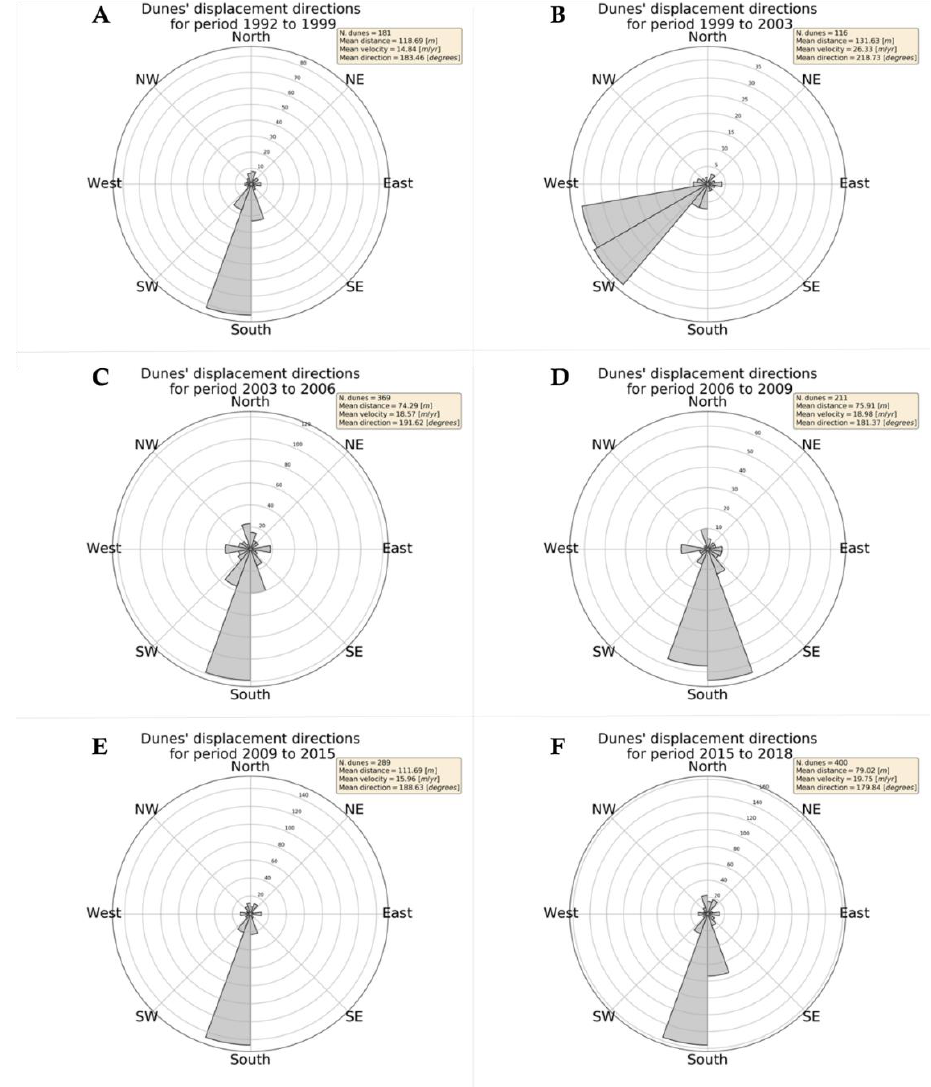
Figure 12. Dune displacement directions for the different periods analyzed, indicating the number of dunes and the mean values of migration distance, migration rate and direction or heading. A), C), E) and F) show dunes displacement direction in SSW direction for the periods 1992-1999, 2003-2006, 2009-2015 and 2015-2018 respectively. B) shows a dunes displacement direction in WSW for the inter-sensor period 1999-2003 and, D) shows a main displacement direction ranging from SSW-SSE for the period 2006-2009. Table 4. Dune migration information obtained using the automatic method over the reference dunes (manually delineated) from the WSM dune field, obtained between 2003 and 2015, specifying distance, velocity, heading direction, mean area and area loss.